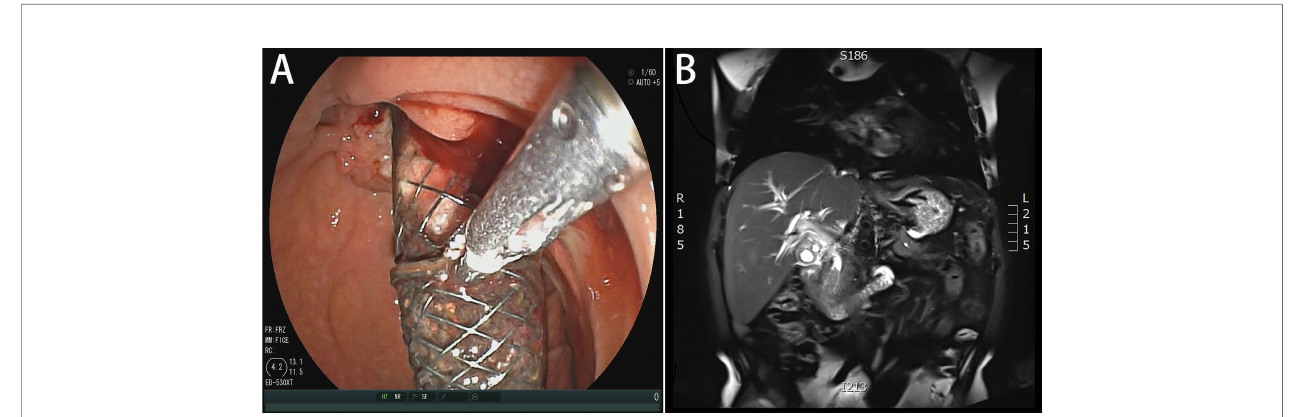
FIGURE 1 | (A) MRCP demonstrated that neoplasm was in the distal common bile duct. (B) Duodenoscopy showed that the biliary stent was fi lled and blocked by tumor tissue and bile